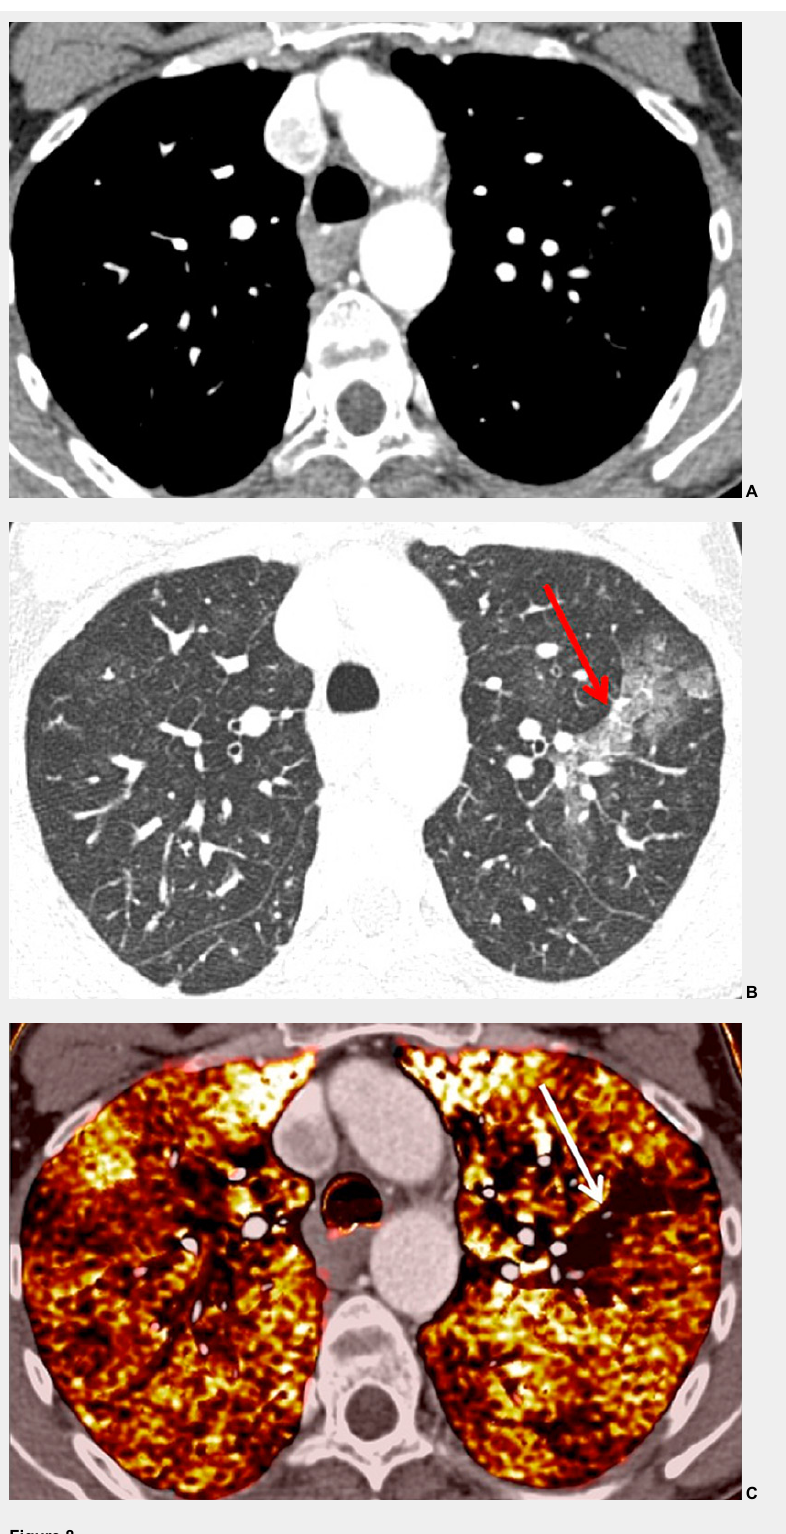
Figure 8 Eisenmenger’s syndrome secondary to a large ventricular septal defect. No vascular abnormalities were seen ( A ) but some ground-glass opacities (arrow) ( B ) with the absence of perfusion corresponded to vascular ground-glass opacities surrounded by clear heterogeneous pulmonary perfusion ( C